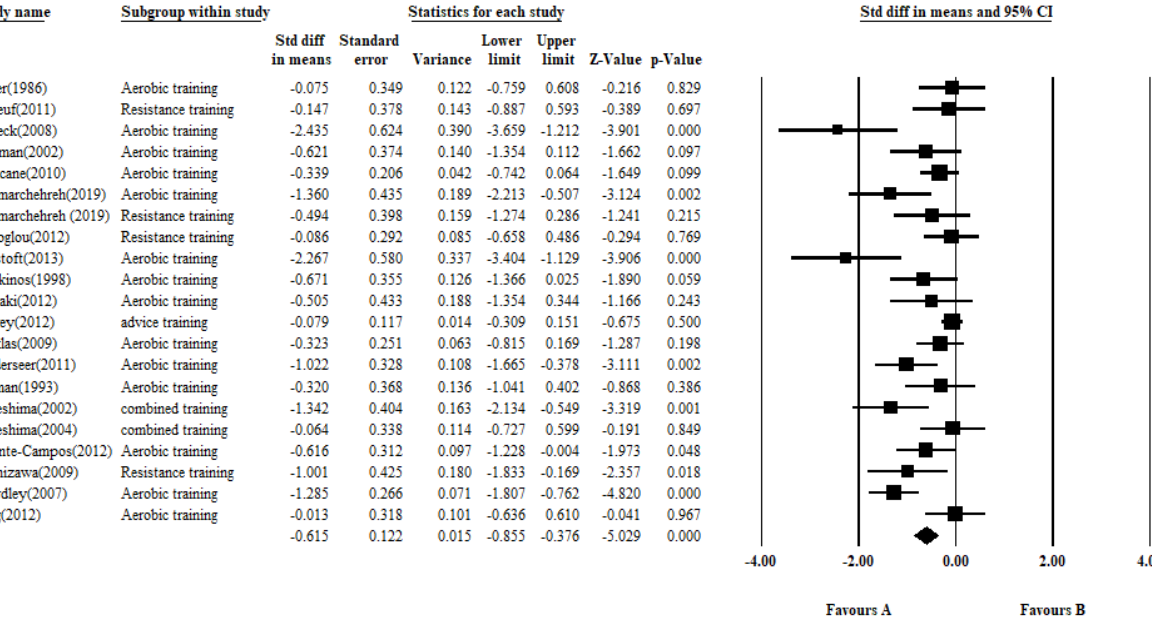
Figure 5. Effects of training on TG (mg/dL), forest plot showings pooled mean differences with 95% CIs for 20 effect sizes obtained from 21 trials (two distinct effect sizes for various modalities were prepared by Ghamarchehreh et al)